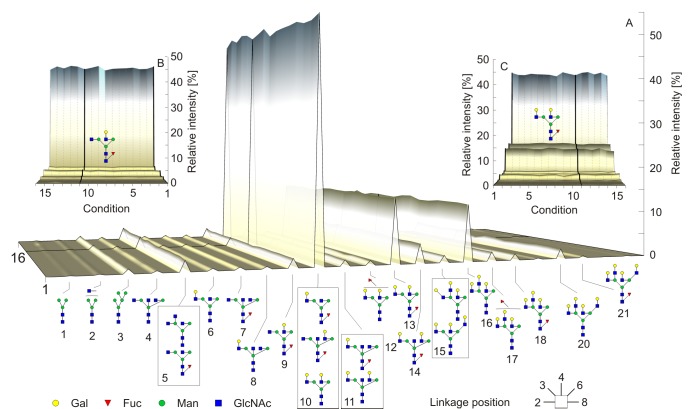
Results of CE-LIF analysis.Average CE-LIF N-glycan profiles (A) from 10 healthy donors under various preanalytical conditions. The conditions are numbered as mentioned in Fig 1. The serum and plasma standard conditions are marked with thick lines. Relative intensities of lower mass (B) and higher mass N-glycans (C) show the similar results throughout various conditions.